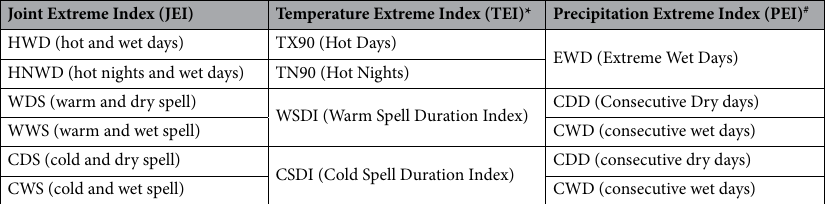
Table 1. List of joint extreme indices and corresponding precipitation and temperature extreme indices. *Details in Table S2. # Details in Table